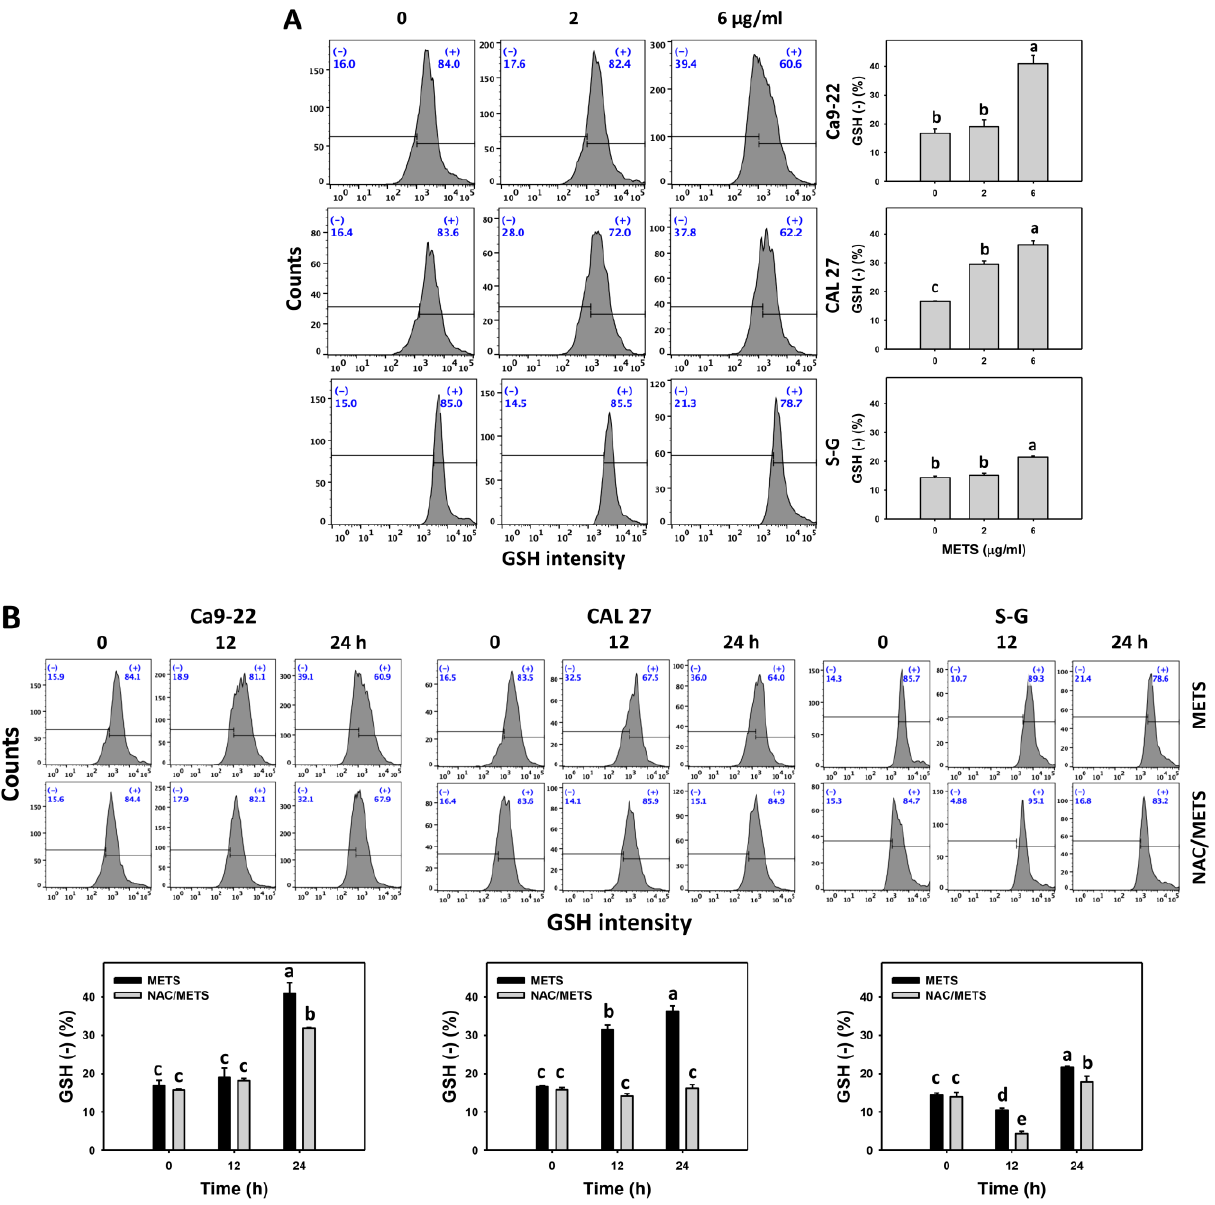
Figure 8. METS depletes the GSH level of oral cancer cells. ( A ) GSH histogram changes. Cells were treated with METS for 24 h. Oral cancer and normal cells (S-G) were included. (+) indicates the high intensity of GSH. ( B ) NAC response on GSH levels. Untreated control and NAC pretreatment were followed by posttreatment of vehicle control and METS (6 μg /mL) for 0, 12, and 24 h, i.e., control, NAC, METS, and NAC/METS, respectively. Data = mean ± SD ( n = 3). Data marked showing non-overlapping lower-case letters have significant results ( p < 0.05) as analyzed by the one-way ANOVA analysis and post hoc test.